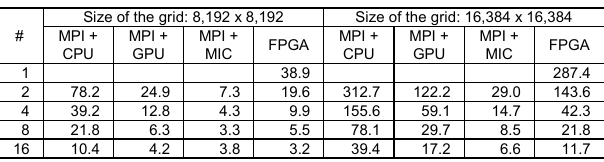
Table 1. Scalability and performance (by second) comparison for GOL computation on clusters of CPUs, GPUs, MICs, and